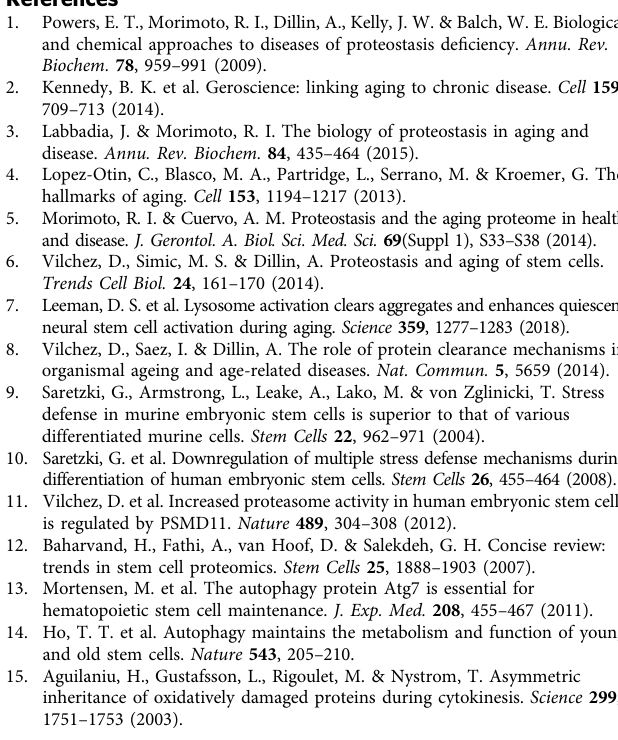
escargot promoter expressed in ISCs and EBs) were sorted using FACS. Total RNA was isolated from sorted cells using Trizol reagent, and used as template to generate RNA-seq libraries for Illumina MiSeq sequencing (150bp paired-end reads were